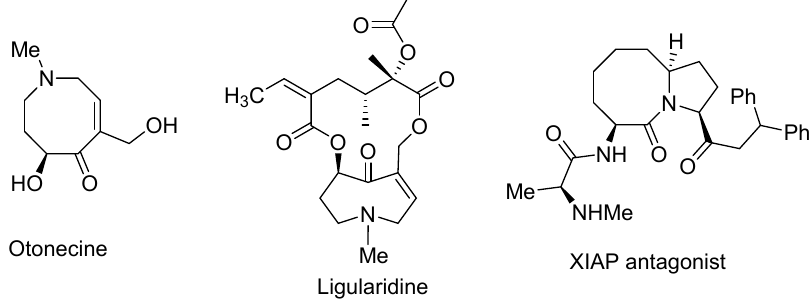
Figure 3. Naturally occurring compounds containing the azocane ring.